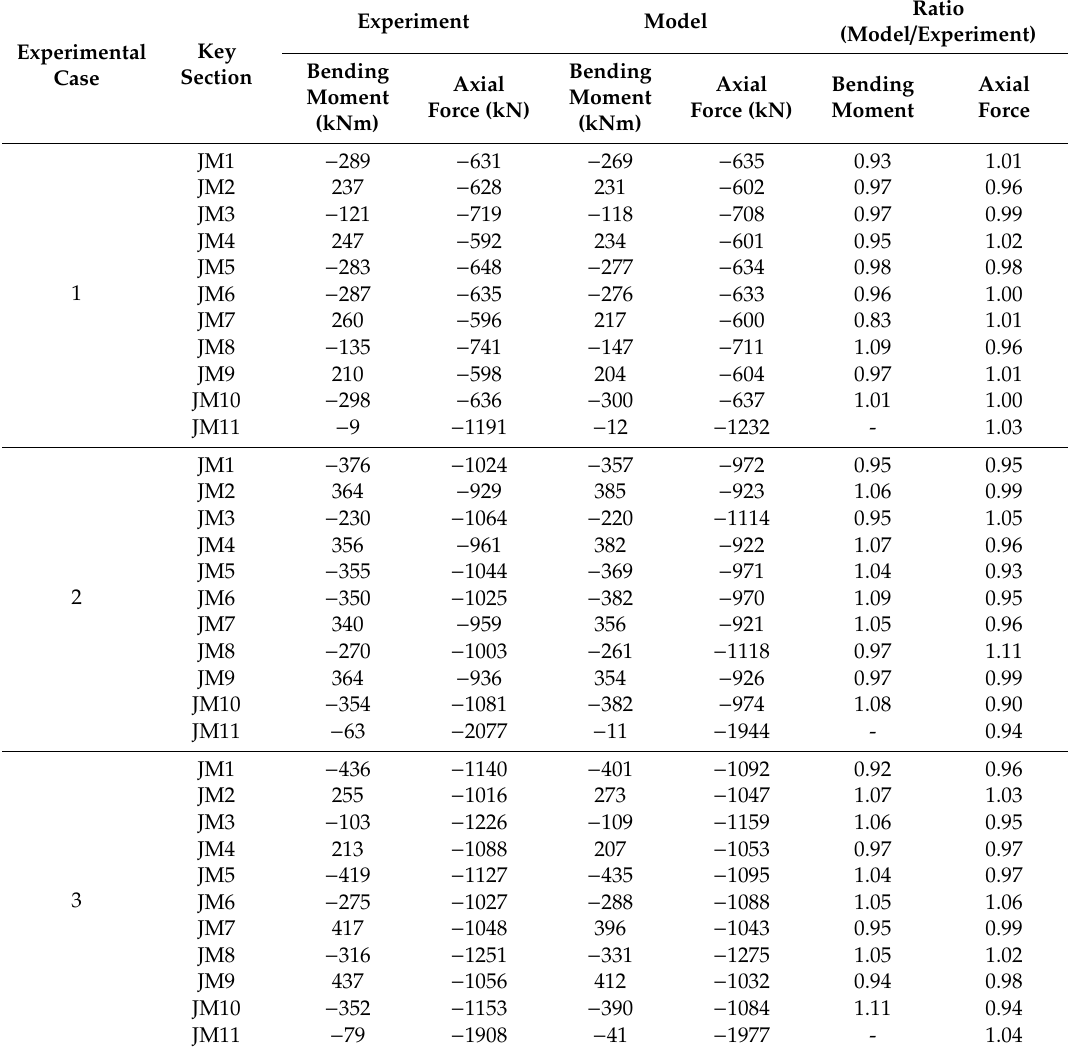
Table 3. Comparison of internal forces.